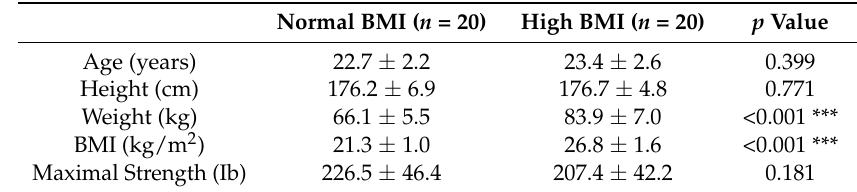
Table 1. Characteristics of the